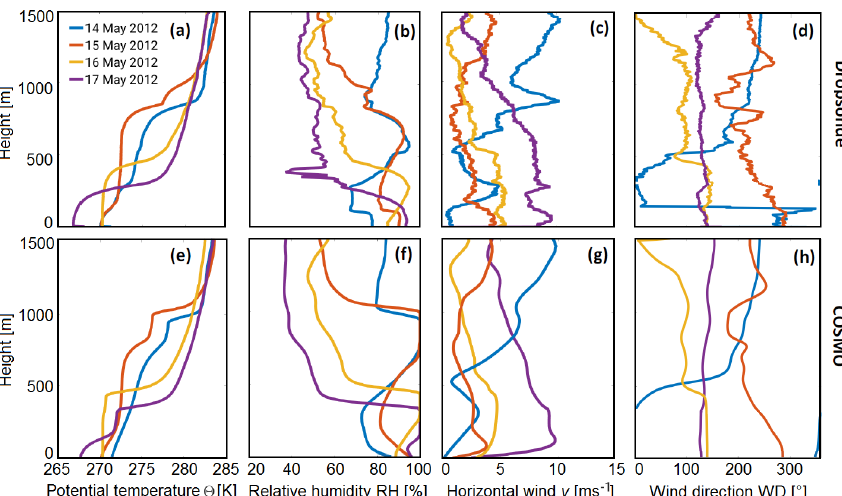
Figure 2. (a, e) Potential temperature, (b, f) relative humidity, (c, g) wind speed, and (d, h) wind direction for the four investigated cases. The dropsonde data are shown in the first row (a–d) and the 2h domain-averaged profiles after spin-up time of the simulations are shown in the second row (e–h) . Dropsondes were released closest to the imaging spectrometer